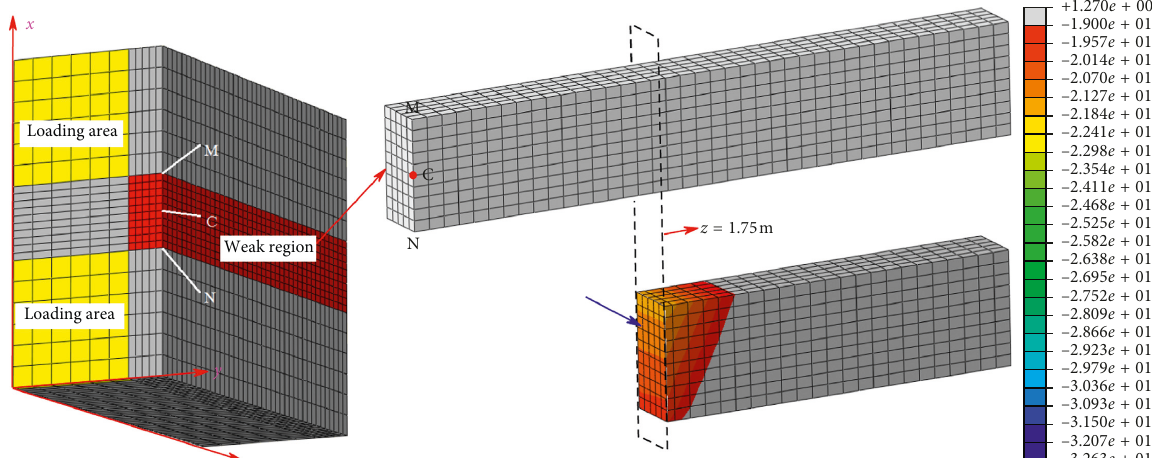
Figure 26: Additional stress subjected to multiple LPPs with a net spacing of